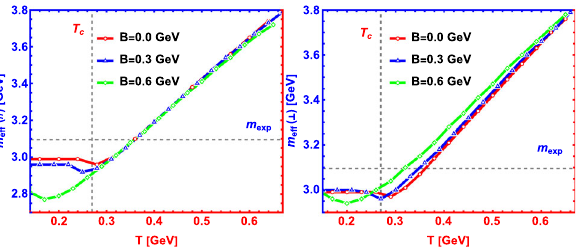
Fig. 2 Theeffectivemassof J /(cid:2) statefordifferentmagneticfield B at μ = 0GeV.Theleftpictureisformagneticfieldparalleltopolarization and the right one is for magnetic field perpendicular to polarization